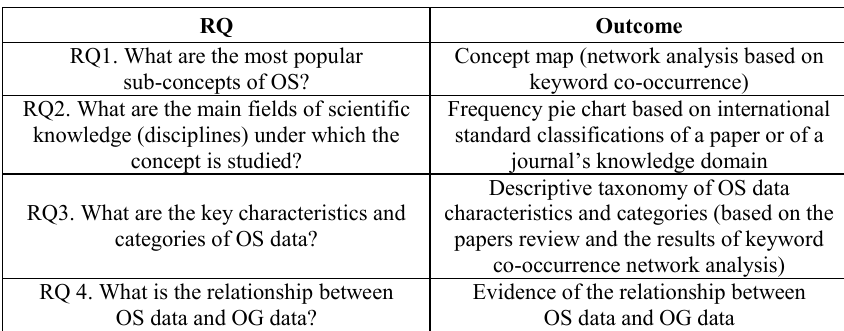
Table 1. Research questions (RQ) and their